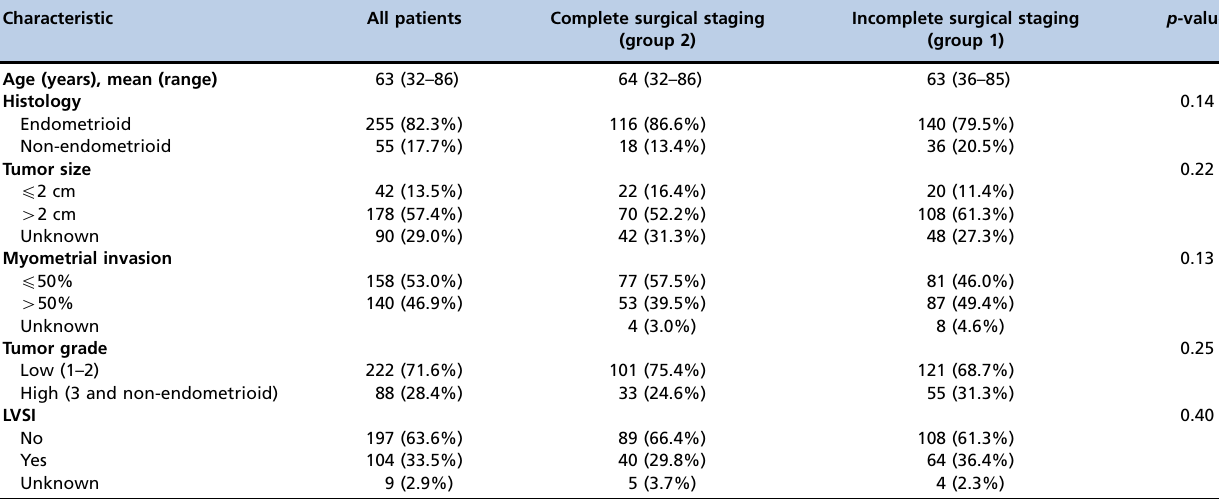
Table 1 - Age and pathological characteristics of 310 patients with endometrial carcinoma. Characteristic All patients Complete surgical staging